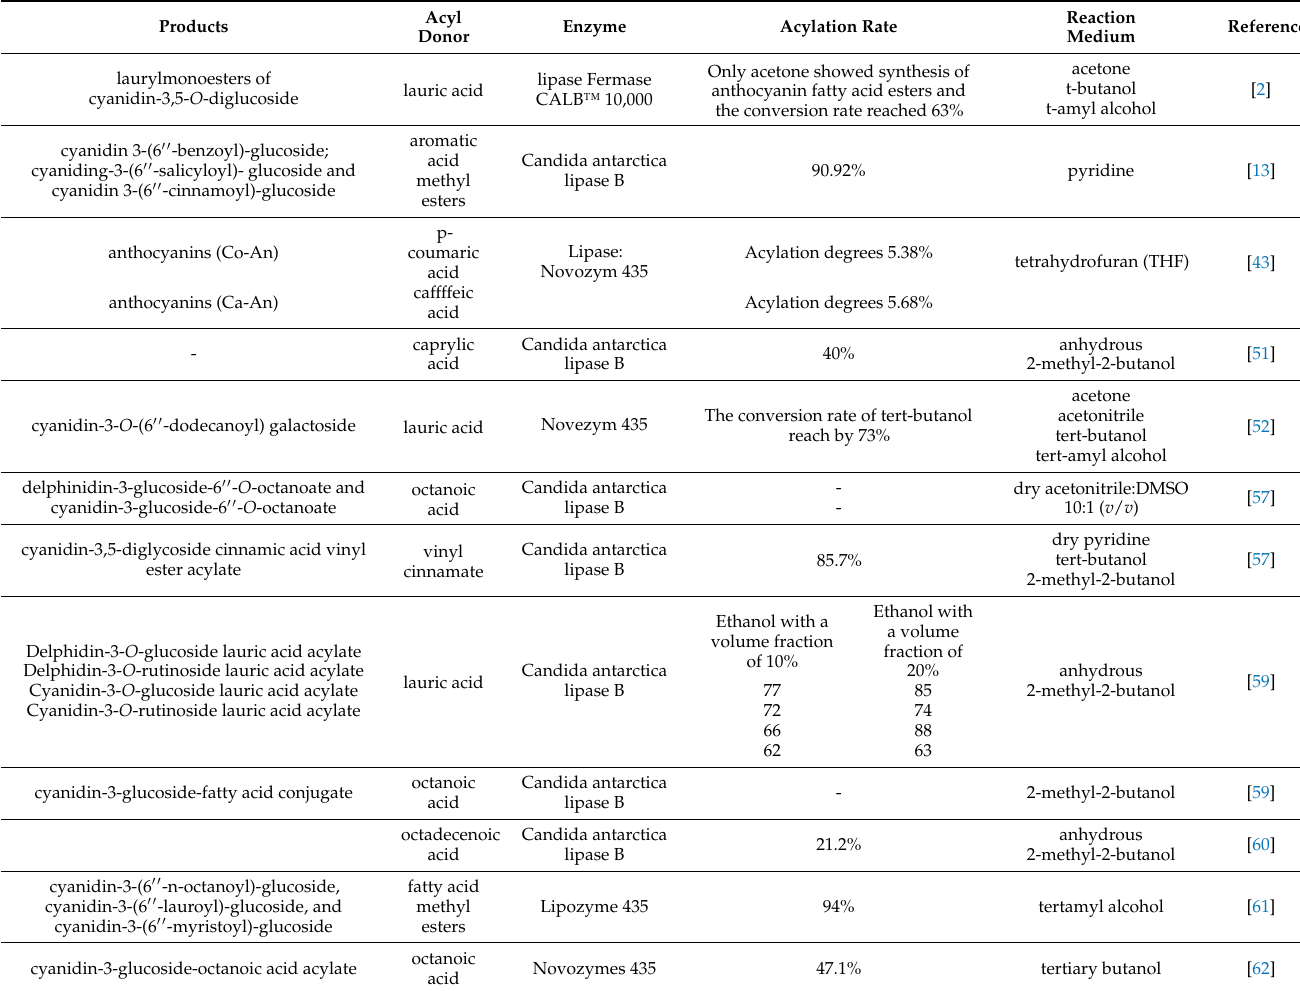
Table 2. Enzymatic acylation conditions and acylation rate of